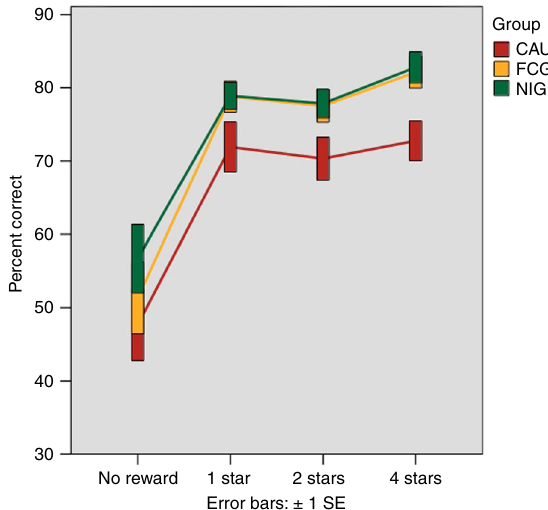
Fig. 2 Percent correct by group and level of incentive on the monetary incentive delay (Piñata) task. Bars are error bars (±1 SEM; N = 48 FCG; N